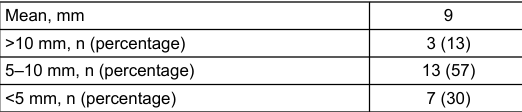
Table 3: Surgical margins in patients with hepatocellular